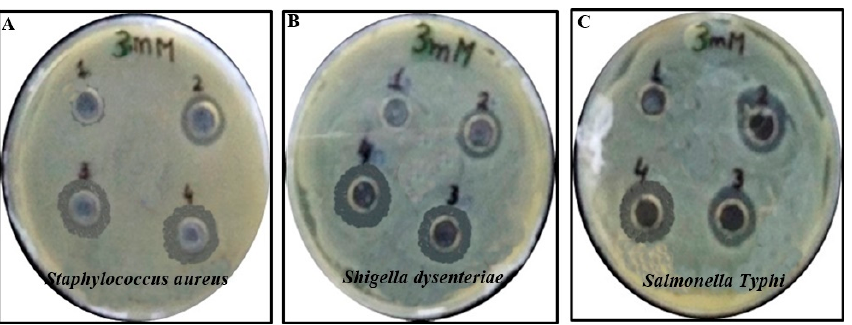
Figure 7. Antibacterial potential (zone of inhibition) of the MS-AgNPs and bare AgNPs was evaluated against ( A ) S. aureus , ( B ) S. dysenteriae , and ( C ) S. typhi; (1) control, (2) antibiotic, (3) bare AgNPs, and (4) MS-AgNPs. Table 1. Zone of inhibition of MS-AgNPs, bare AgNPs, antibiotics, and control against pathogenic